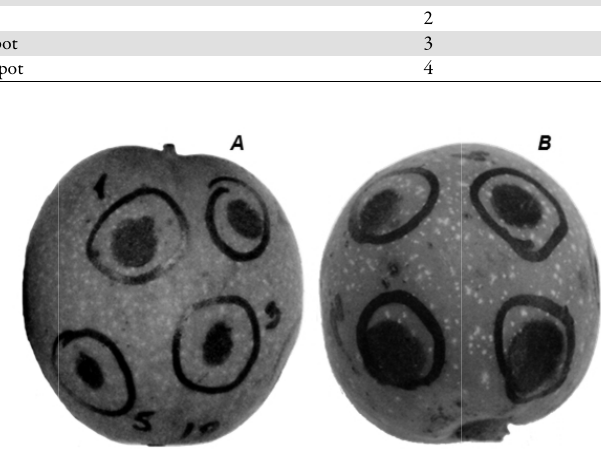
Table 2. The evaluation of disease severity based on the infection of immature walnut fruits Disease appearance/diameter of spots (mm) No symptoms Less than 1.00 mm, superficial and diffuse spots on the inoculation point Slight blackening on the inoculation point of nut by 1.01 mm to 2.00 mm